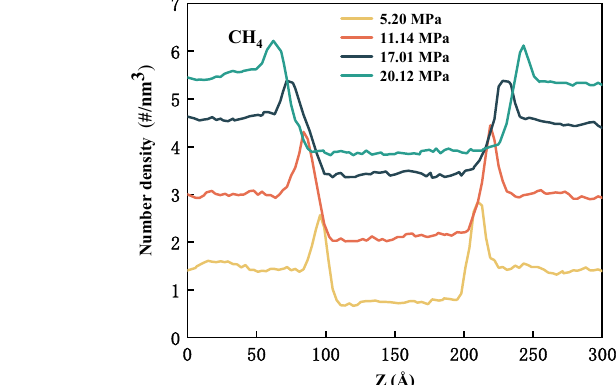
Figure 3. Number density distribution of CH 4 /n-decane at different pressures at 313.3 K. (The # symbol in the unit represents the number of molecules).